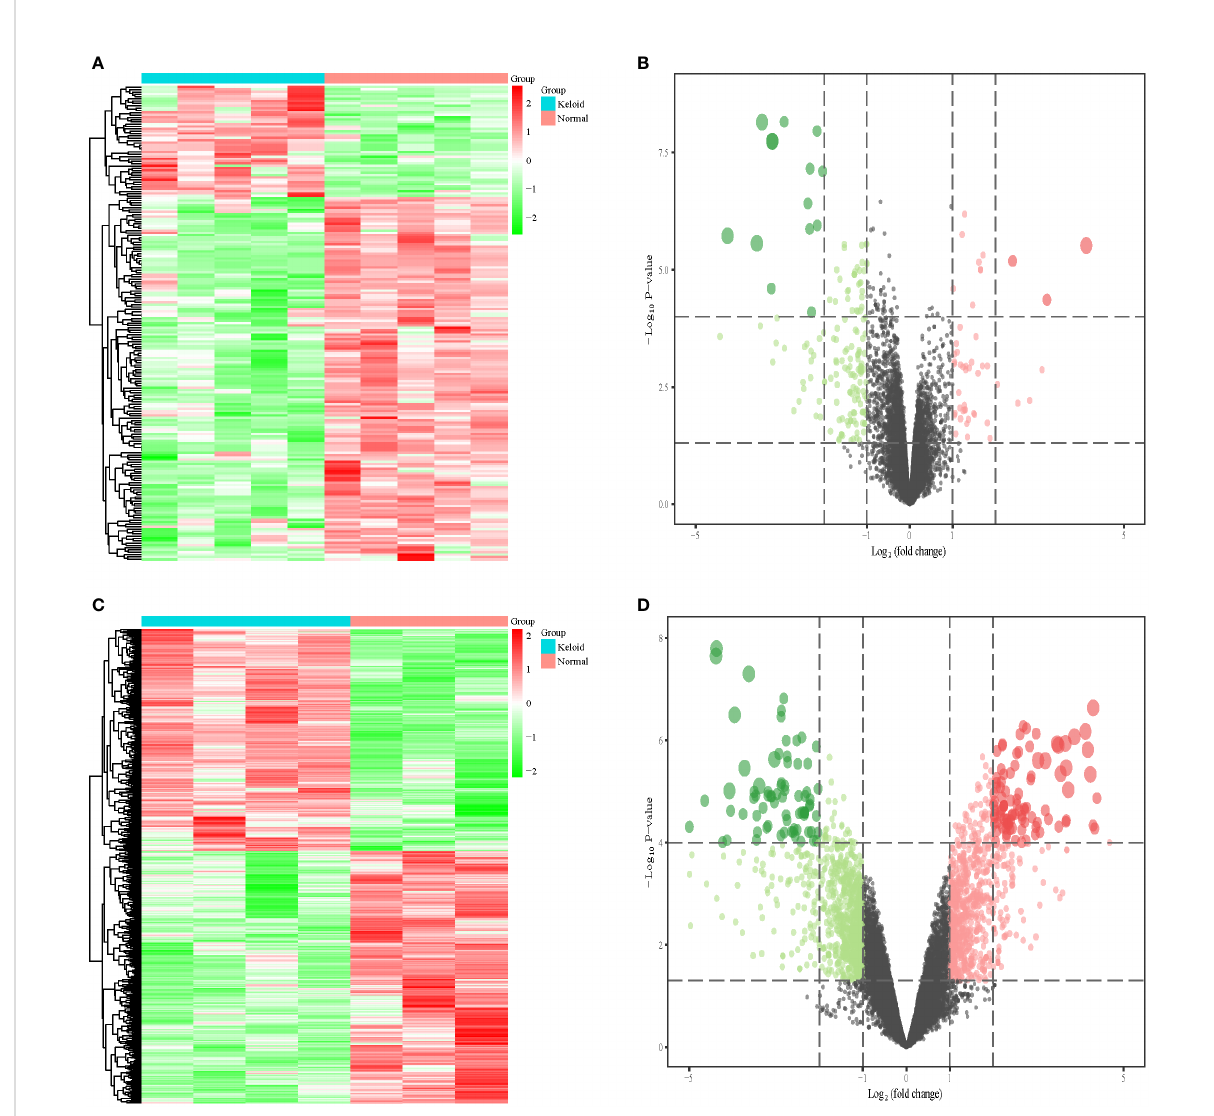
FIGURE 2 Differential expression analysis in three datasets. (A) Heat map of DEGs in GSE7890. (B) Volcano plot of DEGs in GSE7890. (C) Heat map of DEGs in GSE92566. (D) Volcano plot of DEGs in